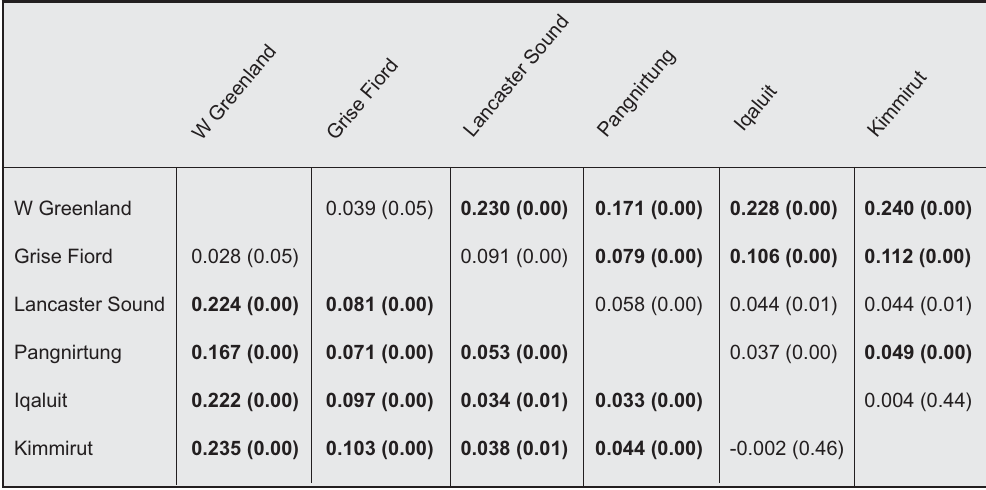
Table 3 . Patterns of mtDNA differentiation among 6 beluga collections in West Greenland and the Canadian High Arctic. F values are above the diagonal, Φ values below, and associated st st probabilities from AMOVA are in parentheses. Minimum significance levels using table-wide criteria and table-wide α = 0.05 were P = 0.006 and 0.0167, and probabilities below this level are bolded.